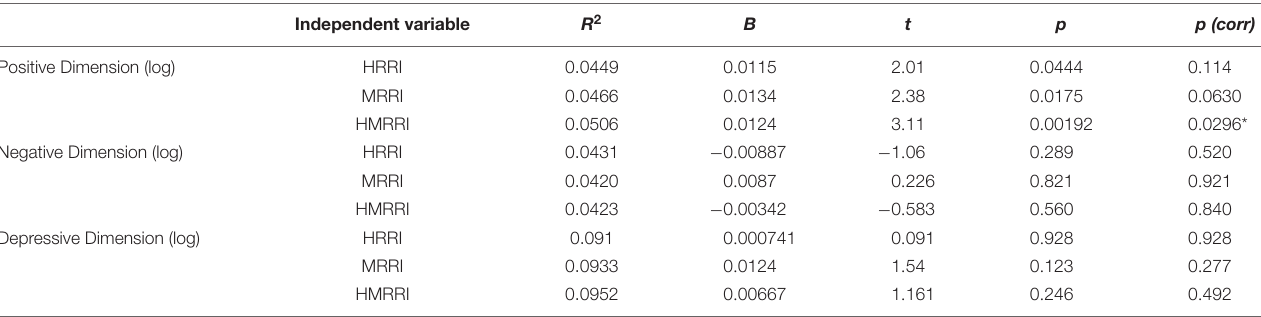
TABLE 2 | Correlations between the clinical dimensions (CAPE-42 subscores) and the genetic